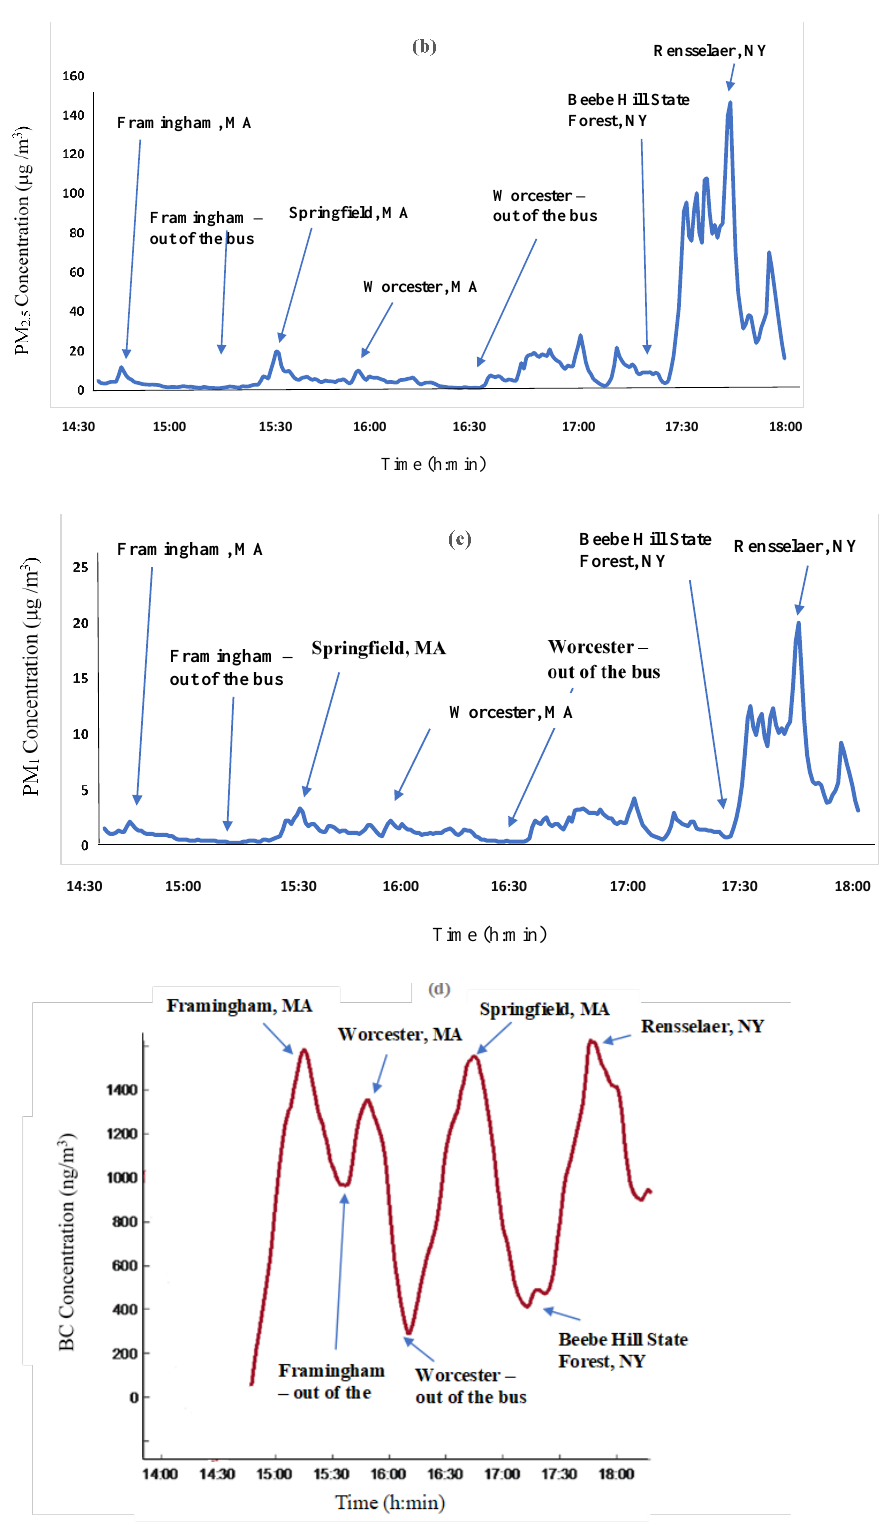
Figure 3. Exposure concentration for a typical bus journey from Boston to Albany during the Campaign: 3 ( a ) PM 10 , ( b ) PM 2.5 , ( c ) PM 1 , and ( d ) BC. The studies showing poor air quality for bus commuters are scarce. Previously, in Hong Kong [28] and Lisbon [34], exposure levels for PM 10 and PM 2.5 buses which were air-conditioned were found to be 74 µg/m 3 and 51 µg/m 3 and 70 ± 82 µg/m 3 and 56 ± 55 µg/m 3 , respectively. Praml and Schierl (2000) measured higher PM 10 concentrations (110–165